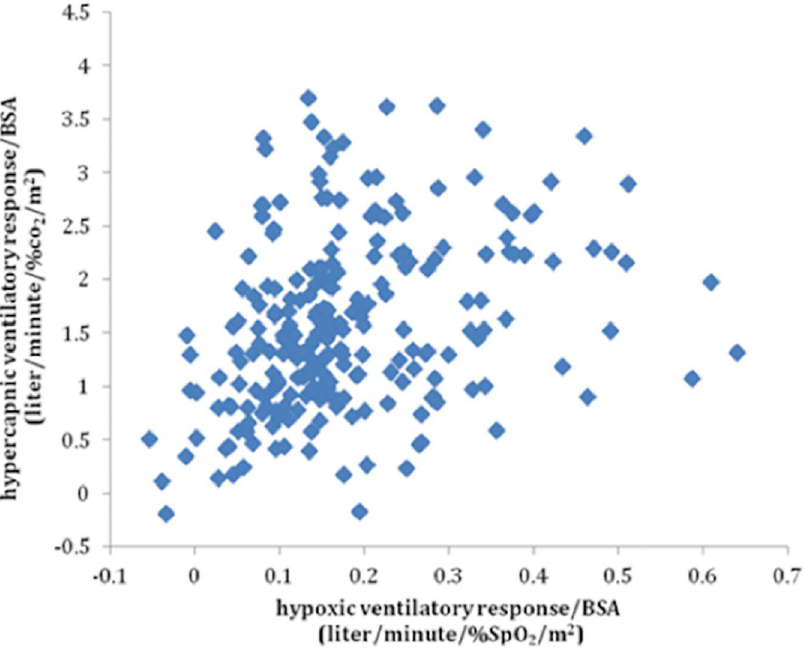
Fig 4. Association between Hypoxic and Hypercapnic Ventilatory Responses. R = 0.392, p <